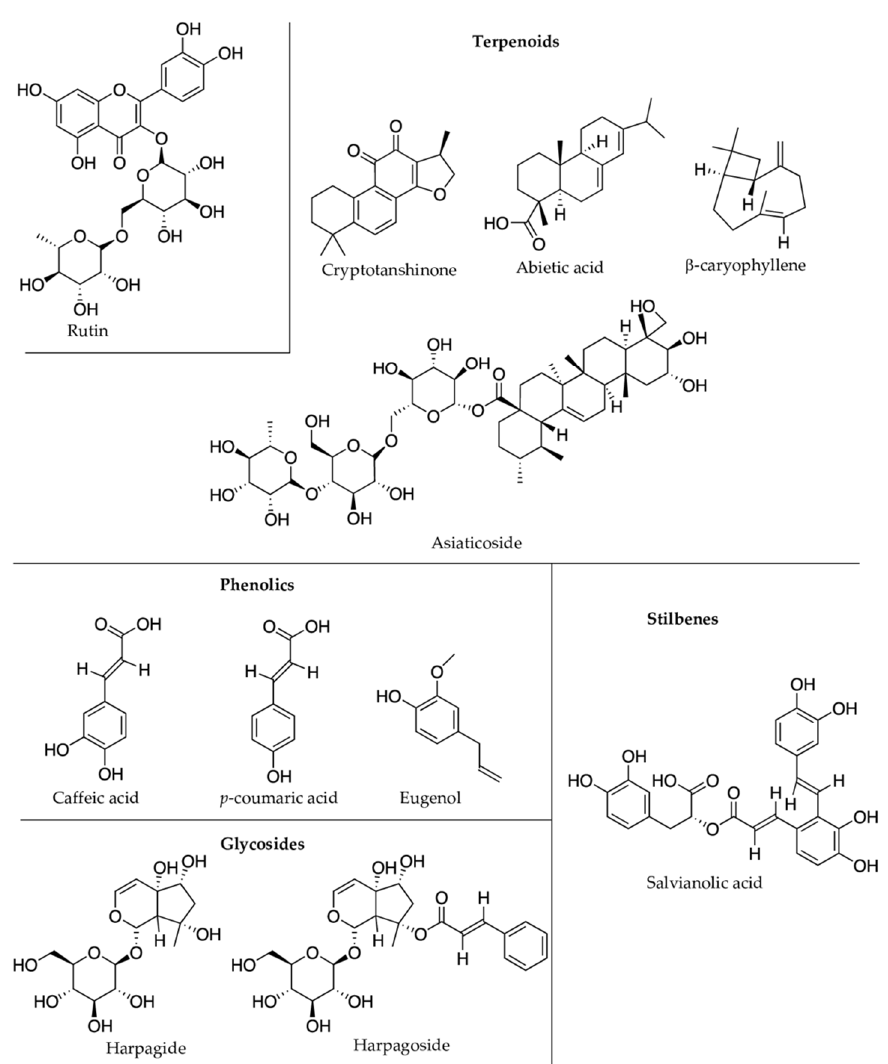
Figure 7. Chemical structure of compounds known to accumulate in plants under various abiotic stress conditions.